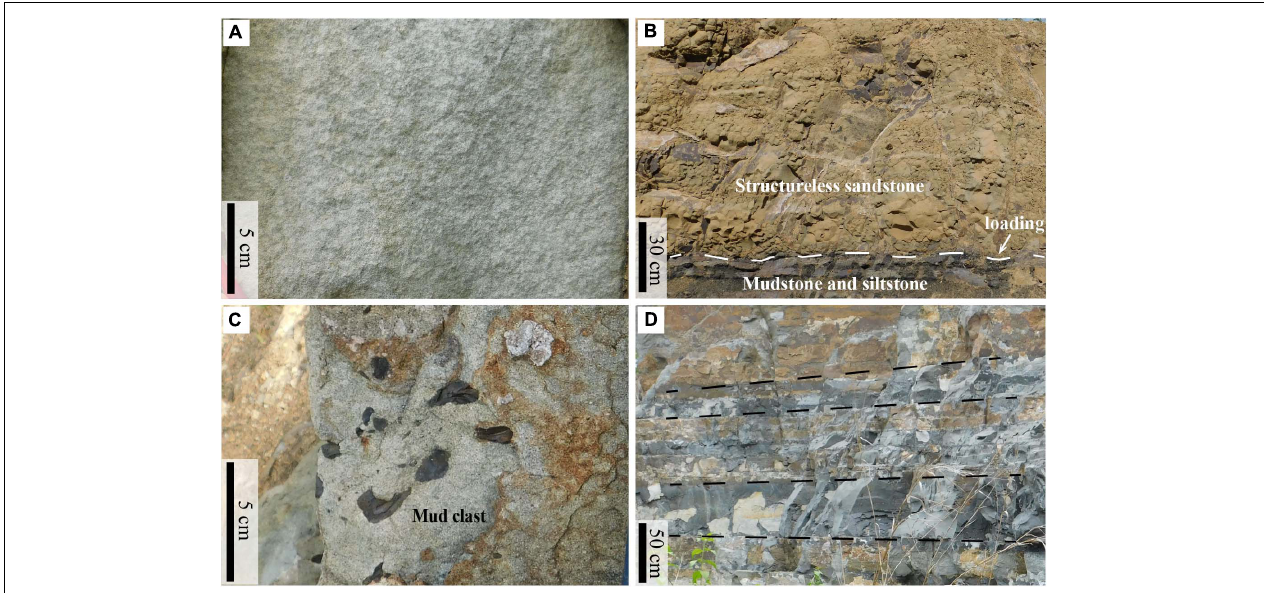
FIGURE 4 | Representative photographs of structureless sandstone facies (F1). (A) Light gray structureless sandstone. (B) Yellowish sandstone with erosional and loading contact with siltstone and mudstone layers. (C) Mud rip-up clasts in sandstone bed. (D) Very fine argillaceous sandstone beds presented near the top of the measured